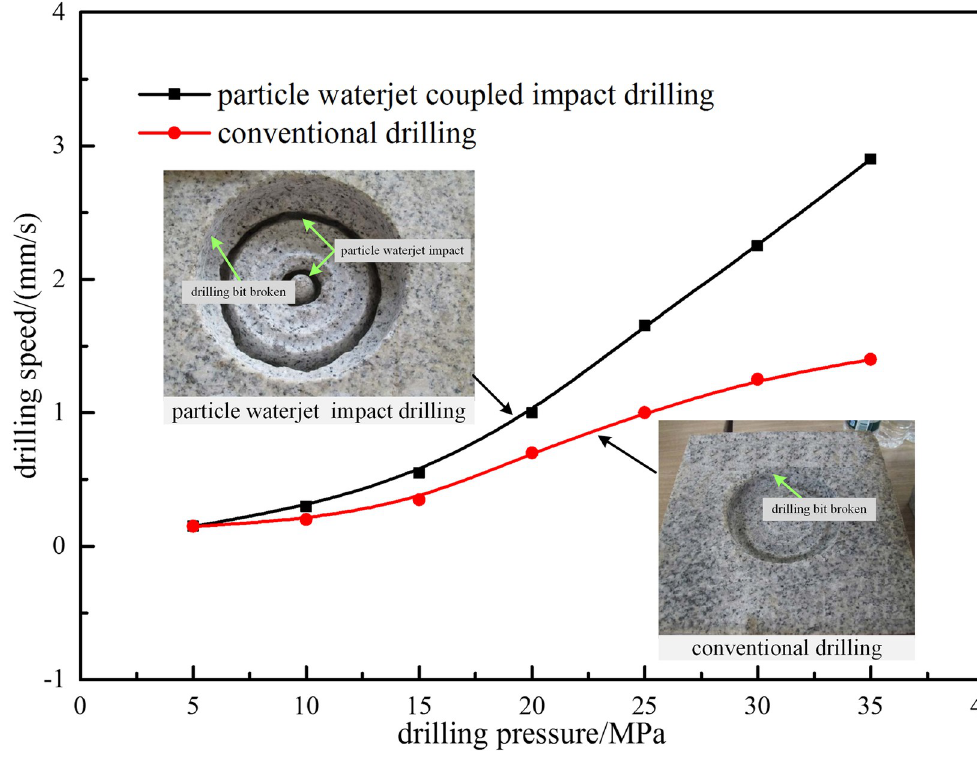
Fig 13. The drilling speed with different drilling